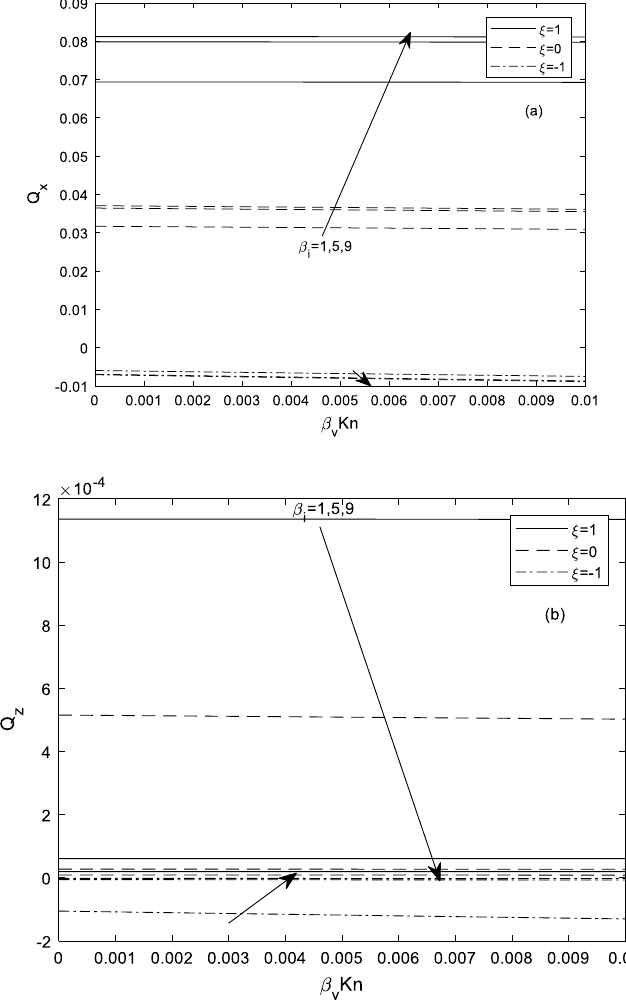
Fig. 17 a Ion-slip current parameter ( β i ) on the main flow and induced volume flow rate for β v Kn = 0.05, S = 0.5, M = 2,ln = 1.667, β h = 0.10 and Pr = 0.71 . b Ion-slip current parameter ( β i ) on the main flow and induced volume flow rate for β v Kn = 0.05, S = 0.5, M = 2,ln = 1.667, β h = 0.10 and Pr =